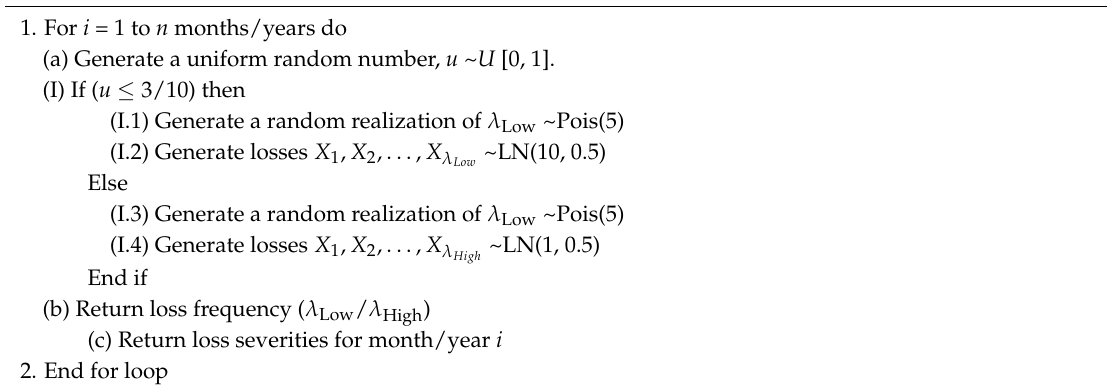
Algorithm A4 Procedure for generating synthetic data corresponding to Scenario (IV) 1. For i = 1 to n months/years